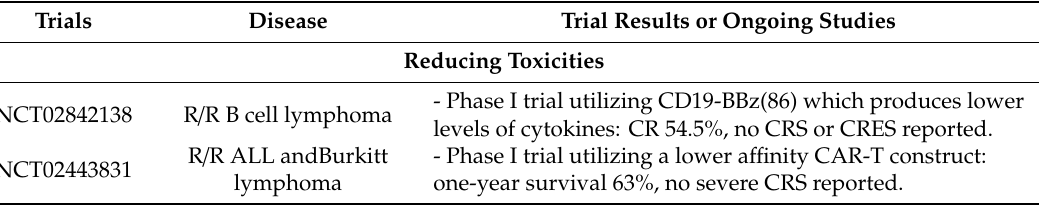
Table 1. Clinical trials with novel CAR